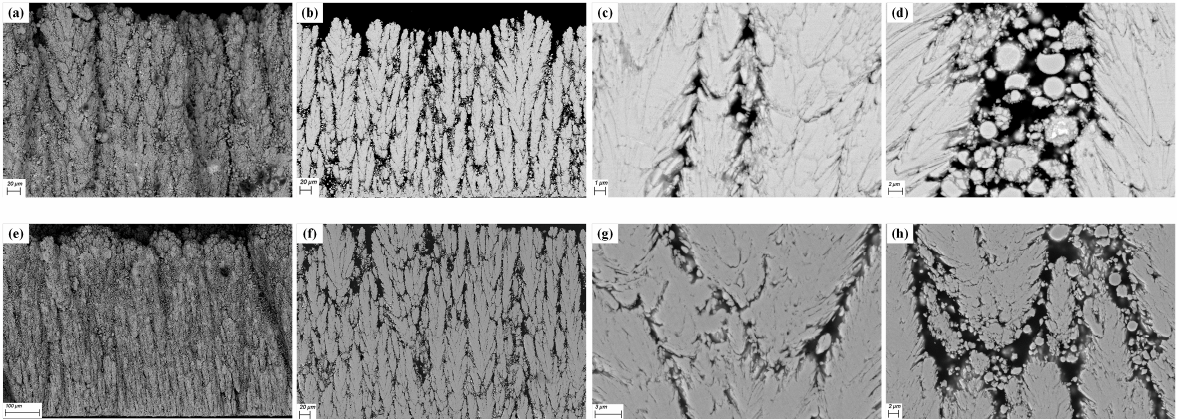
Figure 31. The SEM micrograph of the PS-PVD coatings, ( a ) fractured cross-section of the YSZ coating ( b ) polished cross-section of the YSZ coating ( c , d ) voids and interfaces between small columns of the YSZ coating ( e ) fractured cross-section of the GZO coating ( f ) polished cross-section of the GZO coating ( g , h ) voids and interfaces between small columns of the GZO coating [173].